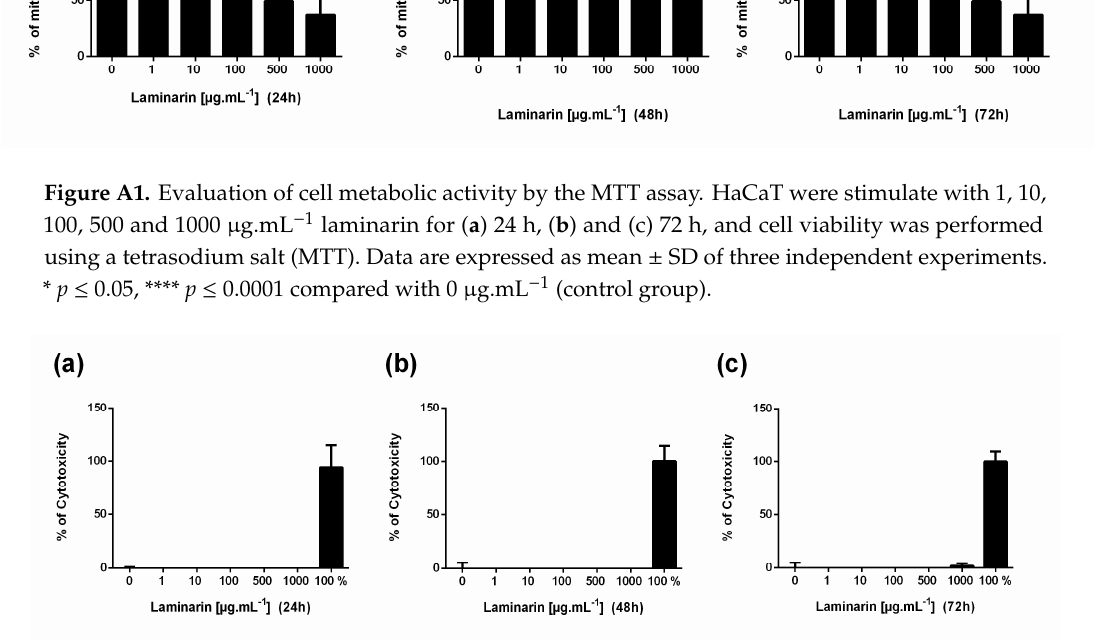
Figure A2. Evaluation of cell cytotoxicity by the LDH cytotoxicity assay. HaCaT cells were stimulated with 1, 10, 100, 500, and 1000 µg.mL − 1 laminarin for 24 h ( a ), 48 h ( b ) and 72 h ( c ) and cell cytotoxicity was performed using a tetrasodium salt (INT). Data are expressed as mean ± SD of three independent experiments.